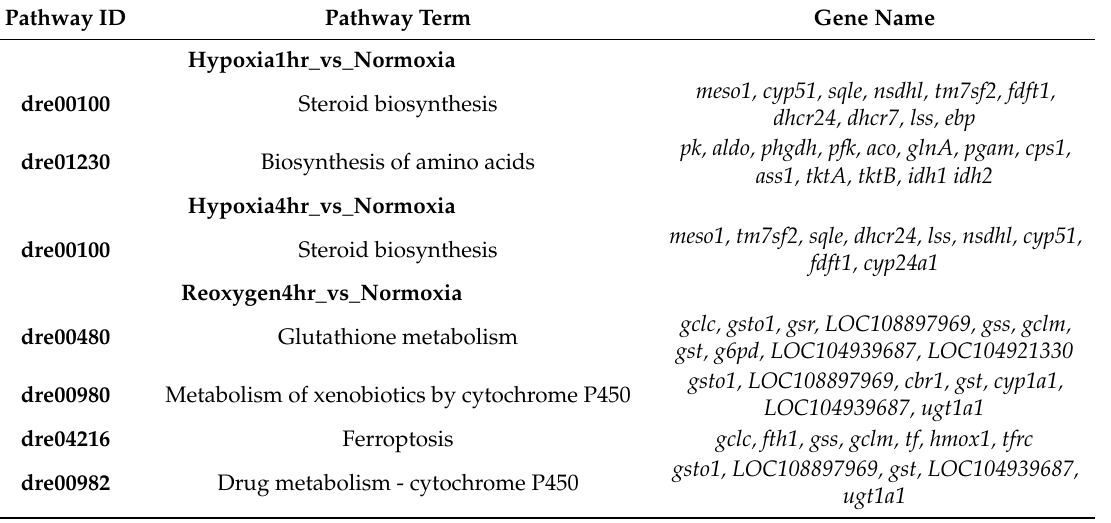
Table 3. Significantly enriched Kyoto encyclopedia of genes and genomes (KEGG) pathways of differentially expressed genes (DEGs) in hypoxia1h_vs_normoxia, hypoxia4h_vs_normoxia and reoxygen4h_vs_normoxia group (padj < 0.05).